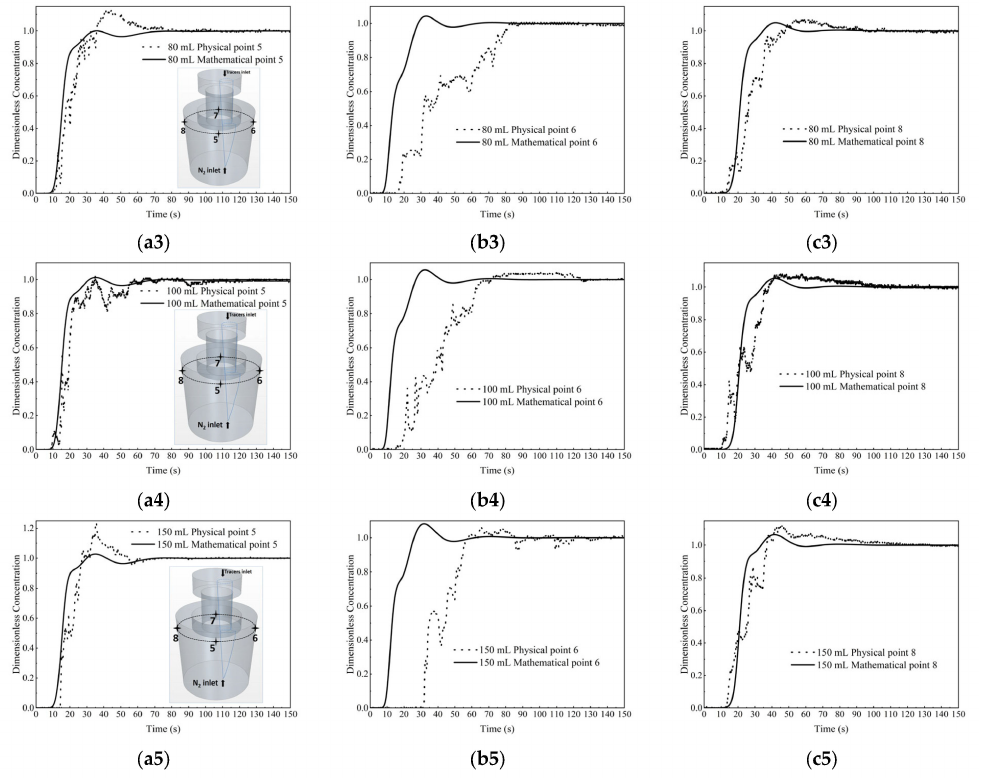
Figure 6. Comparison of dimensionless concentration-time curves between numerical simulation and physical modeling. ( a1 ) 40 mL point 5, ( b1 ) 40 mL point 6, ( c1 ) 40 mL point 8, ( a2 ) 60 mL point 5, ( b2 ) 60 mL point 6, ( c2 ) 60 mL point 8, ( a3 ) 80 mL point 5, ( b3 ) 80 mL point 6, ( c3 ) 80 mL point 8, ( a4 ) 100 mL point 5, ( b4 ) 100 mL point 6, ( c4 ) 100 mL point 8, ( a5 ) 150 mL point 5, ( b5 ) 150 mL point 6, and ( c5 ) 150 mL point 8.